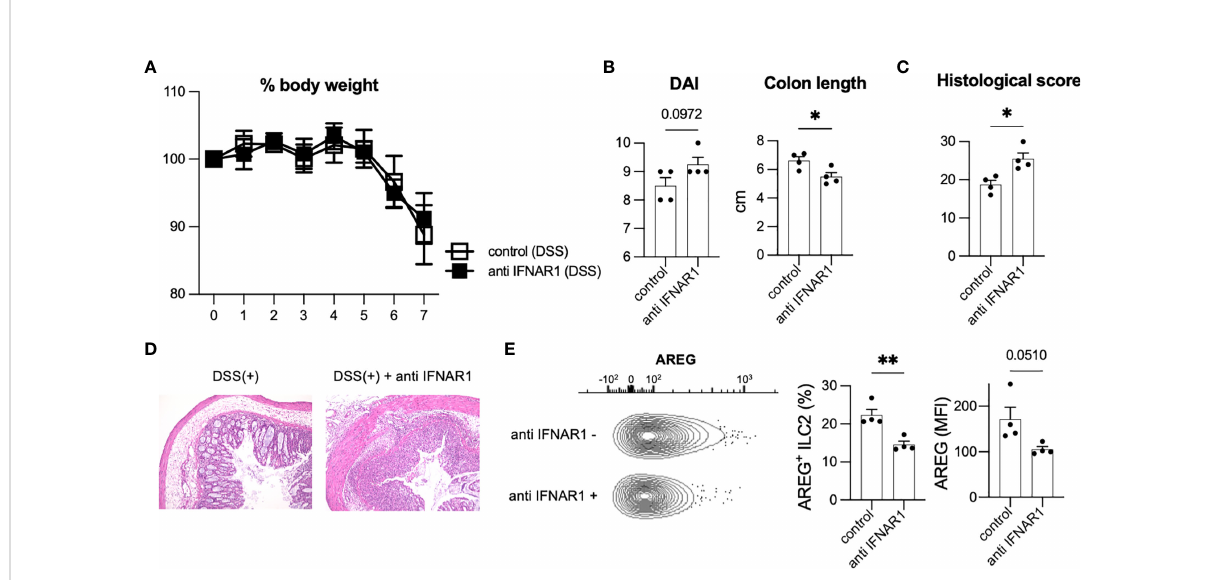
FIGURE 3 Inhibition of T1IFN signaling exacerbated DSS-induced colitis. WT mice were injected anti-IFN-alpha/beta receptor1 (IFNAR1) antibody intraperitoneally (i.p.) on day 0 and administered DSS (n=4 for each group). (A) Change in % body weight relative to initial body weight of control (DSS treated) mice (n=4) and anti IFNAR1 i.p. injected (DSS treated) mice (n=4). (B) Disease activity index (DAI) score on day 7 and colon length of mice of each group (n=4 for each group). (C, D) Histological score (n=4 for each group) and histopathology of distal colon. (E) Amphiregulin (AREG) expression in ILC2s of control mice and anti-IFNAR1 treated mice. Representative contour plots showing AREG expressing ILC2s in control mice (DSS treated) and anti IFNAR1 i.p. injected mice (DSS treated). Frequency of AREG expressing ILC2s among all ILC2s and mean fl uorescence intensity (MFI) of AREG in ILC2s (n=4 for each group). Data are mean and SEM. * P < 0.05, ** P <